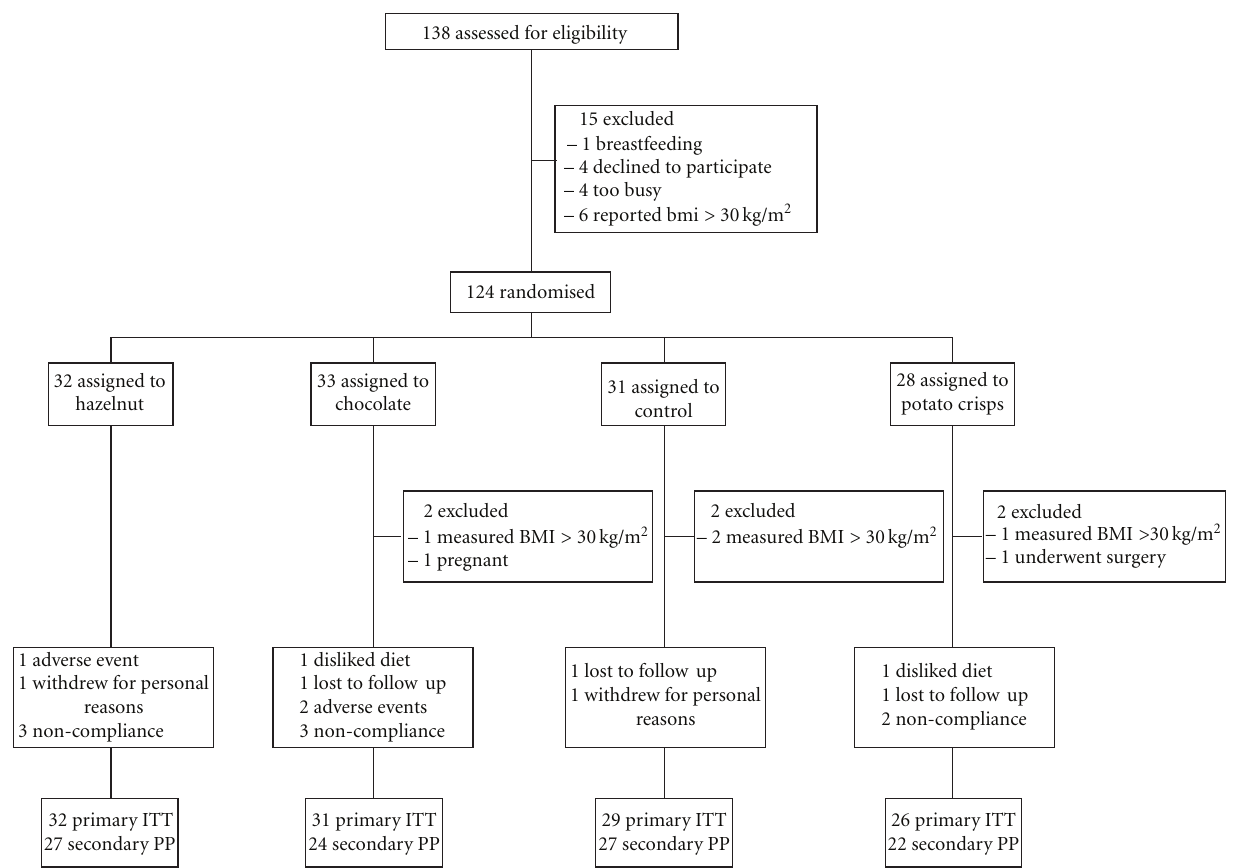
Figure 1: Flowchart of study